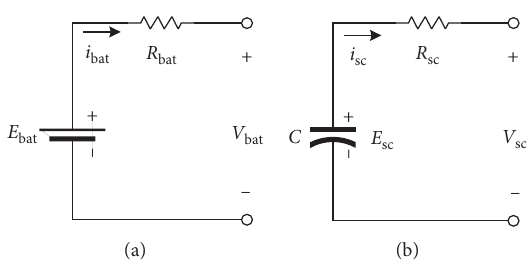
Figure 2: The models of battery and super-capacitor. (a) Battery. (b)